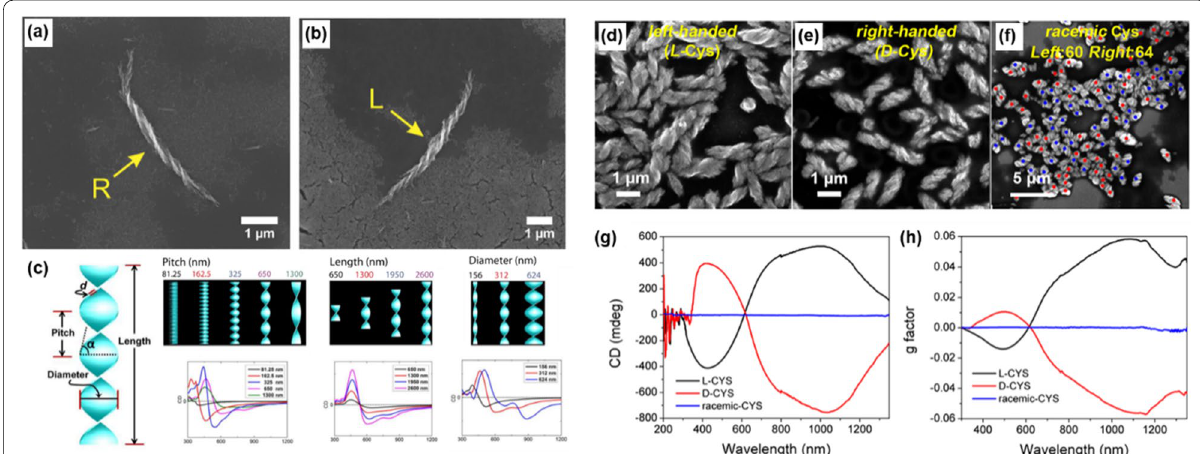
Fig. 17 SEM images of a d -Cys CdTe NP assembly and b l -Cys CdTe NP assembly. c Illustration of the various geometrical parameters in a typical CdTe helix ( d represents a thickness) and simulated CD spectra with geometrical parameters of the variables (pitch, length, and diameter). Reproduced with permission from [103]. Copyright 2017 AAAS. SEM images of helices made with d l -, e d -, and f rac -Cys surface ligands. For SEM images obtained in case of rac-Cys red and blue dots are used to mark the left-handed and right-handed helices, respectively. g CD and h g-factor spectra made with (black) l -, (red) d -, and (blue) rac-Cys surface ligands. Reproduced with permission from [104]. Copyright American Chemical Society,